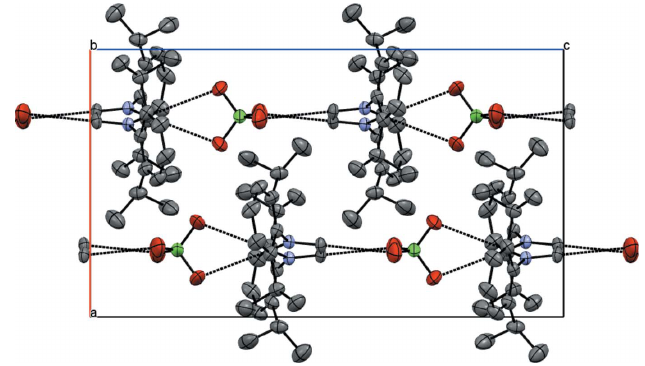
Figure 2 Packing diagram viewed along the [010] axis showing the hydrogen- bonding interactions.